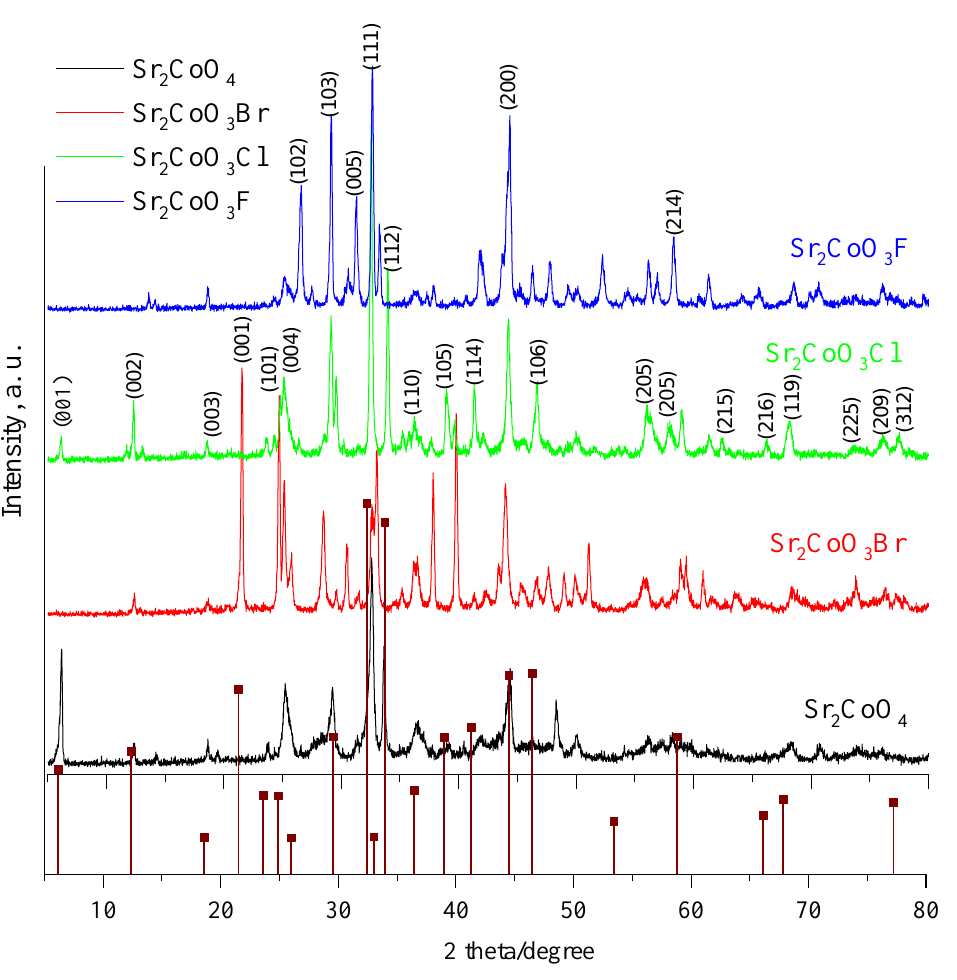
Figure 1. XRD patterns of strontium cobalt oxyhalide catalysts.